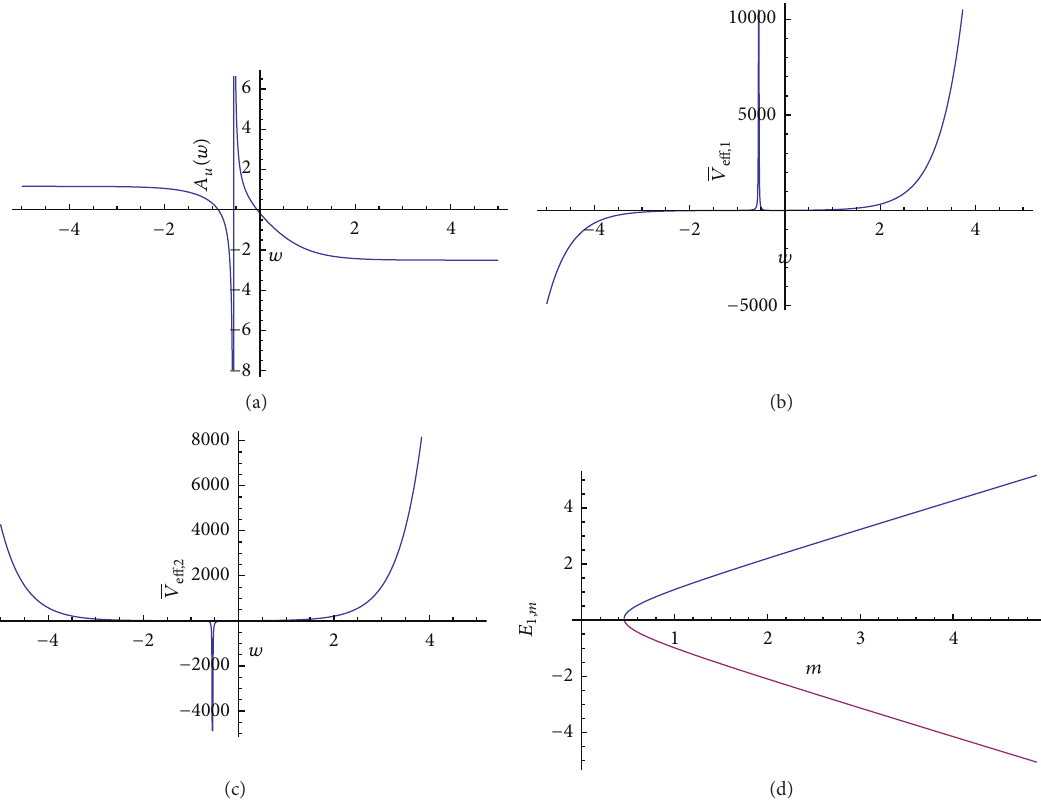
(35) and (c) 𝑉 (36), and (d) the eff ,1 eff ,2